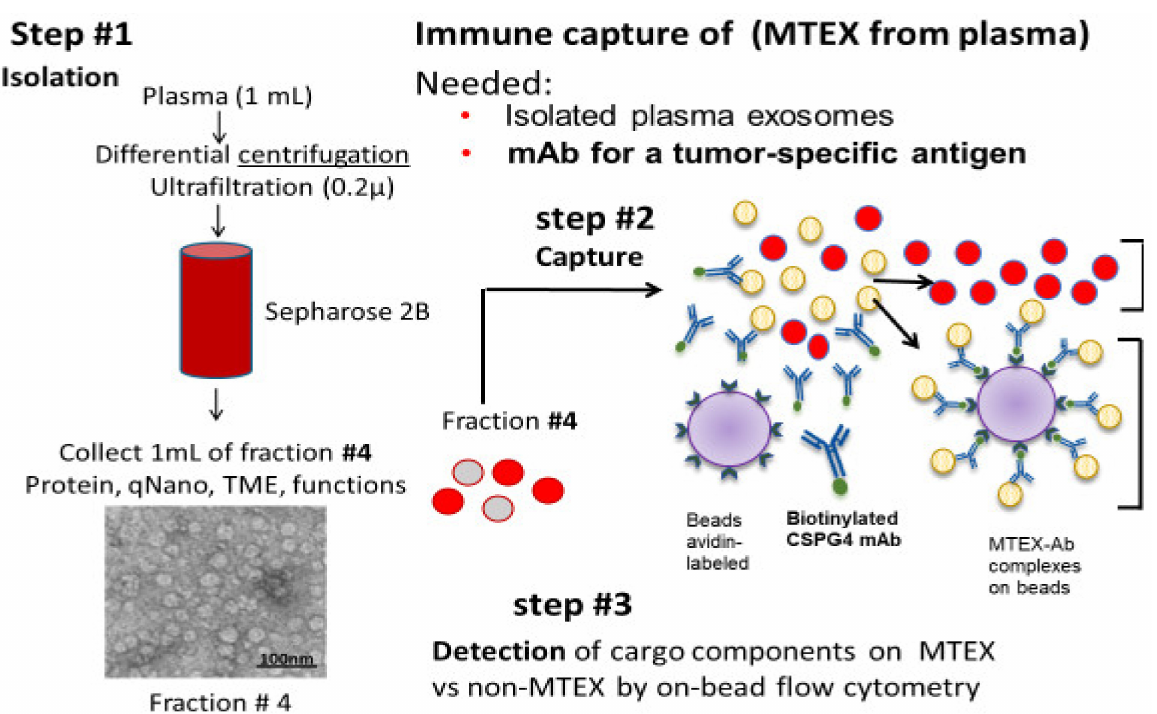
Figure 1. Immune capture with biotinylated anti-CSPG4 Abs of melanoma cell-derived exosomes on streptavidin-labeled beads from plasma of patients with melanoma. Exosomes were first isolated from plasma by size exclusion chromatography (SEC; step #1). Fraction #4 containing a mix of melanoma cell-derived vesicles (MTEX) and vesicles derived from non- malignant cells (NMTEX) were immuno-captured (step #2) Non-captured exosomes (NMTEX) in red were re-captured on beads with anti-CD63 mAbs for detection by on-bead flow cytometry (step #3). Two different clones of CSPG4 mAb (763.74 and 225.28) specific for distinct epitopes of this protein were used for capture and detection, respectively. Reproduced with changes from Sharma et al., Ref #